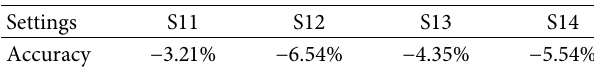
Table 6: Performance decrement ( − )/increment (+) of different algorithms on [6].